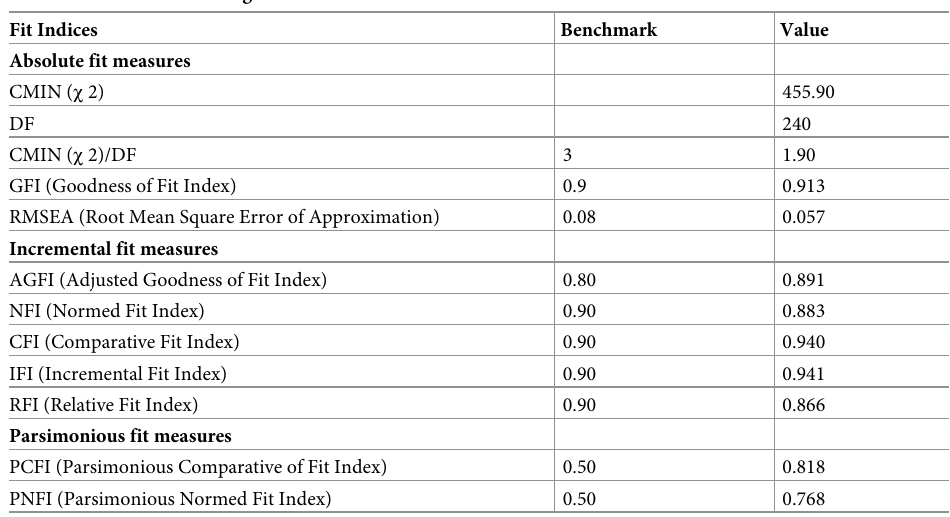
Table 3. Results of the fitting